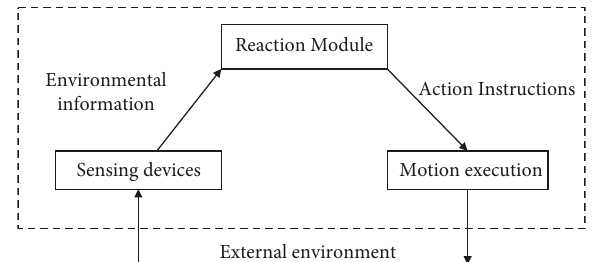
Figure 3: Structure of reactive intelligences.